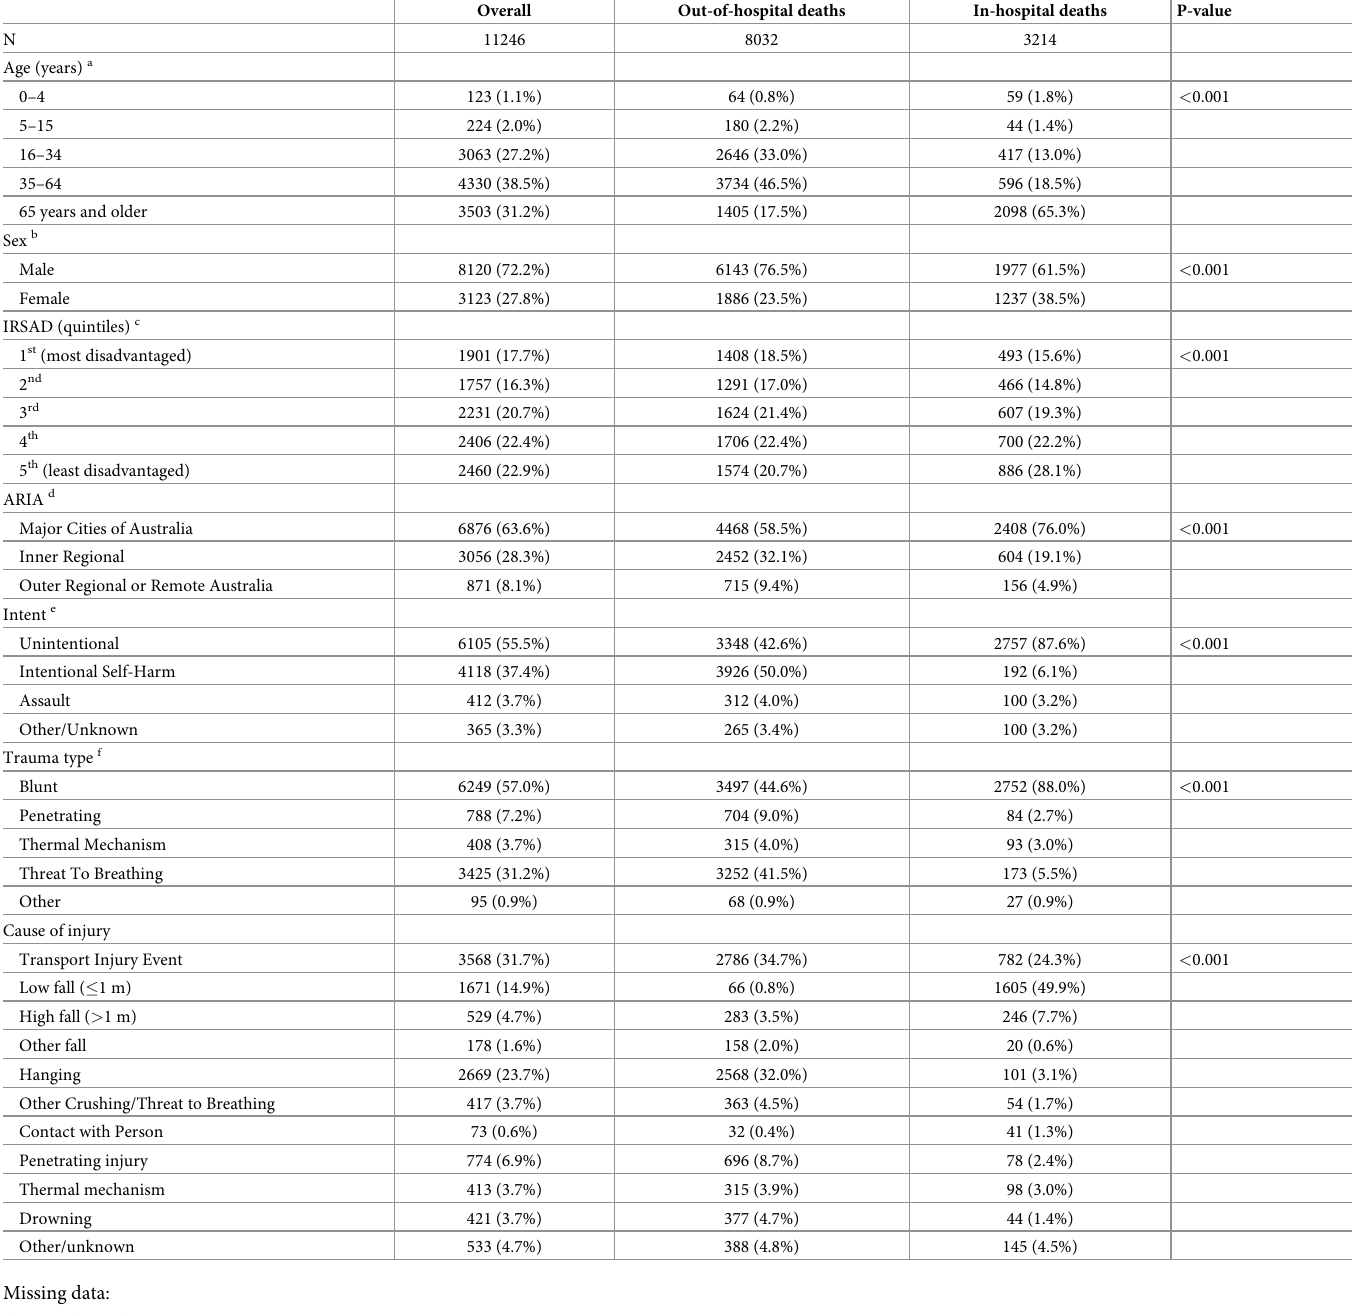
Table 1. Demographic and injury data presented as overall, and for out-of-hospital and in-hospital trauma deaths. P-values reflect differences between out-of-hos- pital and in-hospital trauma